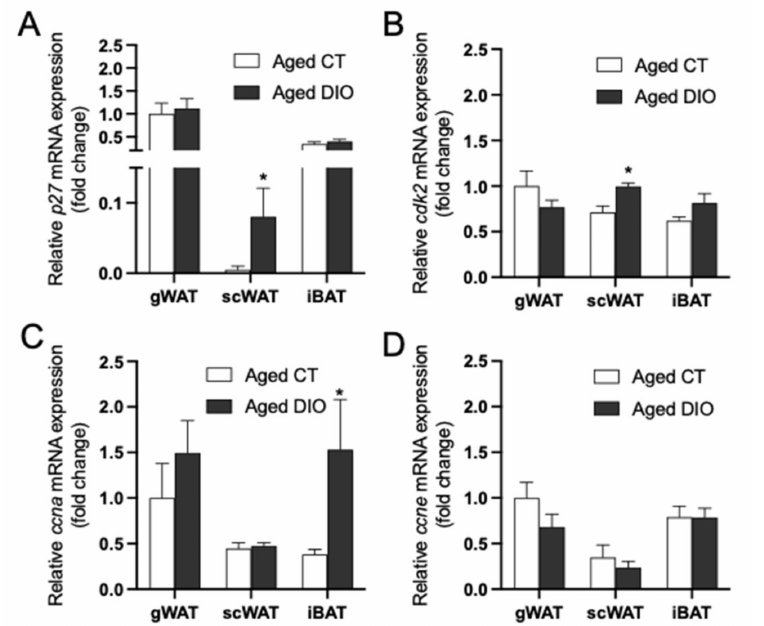
Figure 4. Effect of diet-induced obesity (DIO) on the expression of p27 ( A ), cdk2 ( B ), ccna ( C ), and ccne ( D ) in gWAT, scWAT and iBAT from aged (18-month-old) female mice. Data (mean ± SEM) are expressed as fold change of Aged CT gWAT considered as 1. * p < 0.05 vs. aged CT mice ( n = 5–9). To further study the role of p27 and cdk2 in obesity, correlation analyses among gene expression levels and the adipose tissue weights were performed for each depot (Table 1). A positive association between ccna and gWAT mass was observed and higher levels of p27 and cdk2 were associated to a larger scWAT depot size. Increased levels of cdk2 were also associated with elevated levels of leptin ( Lep ) in scWAT (Supplemental Table S1). Additionally, increased cdk2 and ccna mRNA levels were associated to heavier iBAT